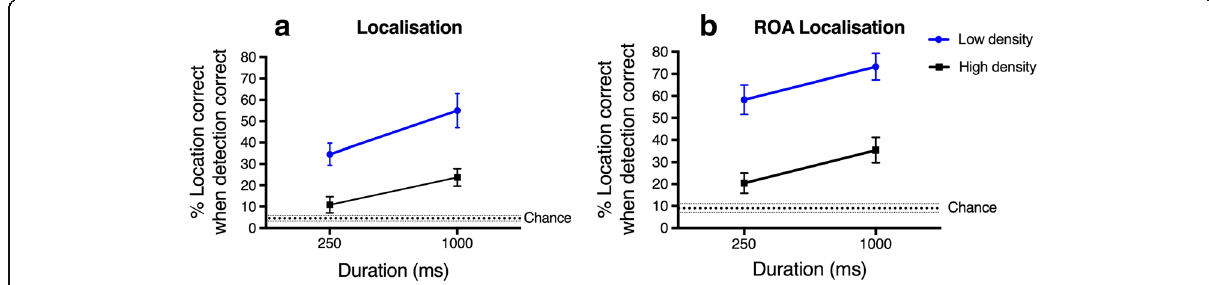
Fig. 4 Detection and localisation results. a Average percentage correct on the localisation task for trials when detection was correct; b Average percentage correct on the localisation task when a region of acceptance (ROA) around the lesion is included. Chance is 4.4% and adjusted to 9.1% when including the ROA ( dotted line ) with 95% confidence intervals. Error bars represent 95% confidence